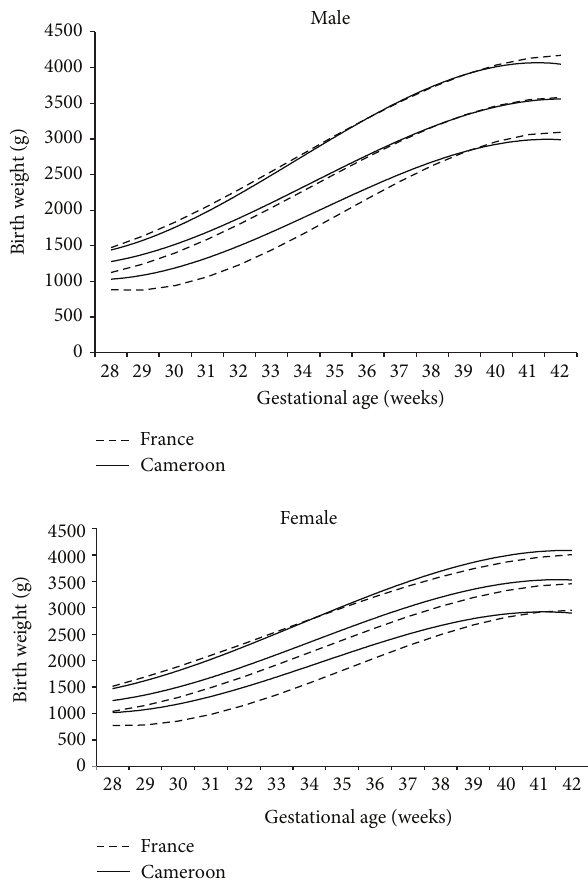
Figure 6: 10th, 50th, and 90th percentile curves of birth weights of male and female Cameroonian infants compared to French infants.